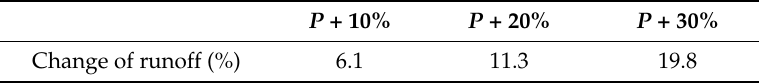
Figure 13. Sensitivity of runoff under different precipitation variations relative to the period 2007–2011. Table 6. Change of runoff under various changes of precipitation ( P ).